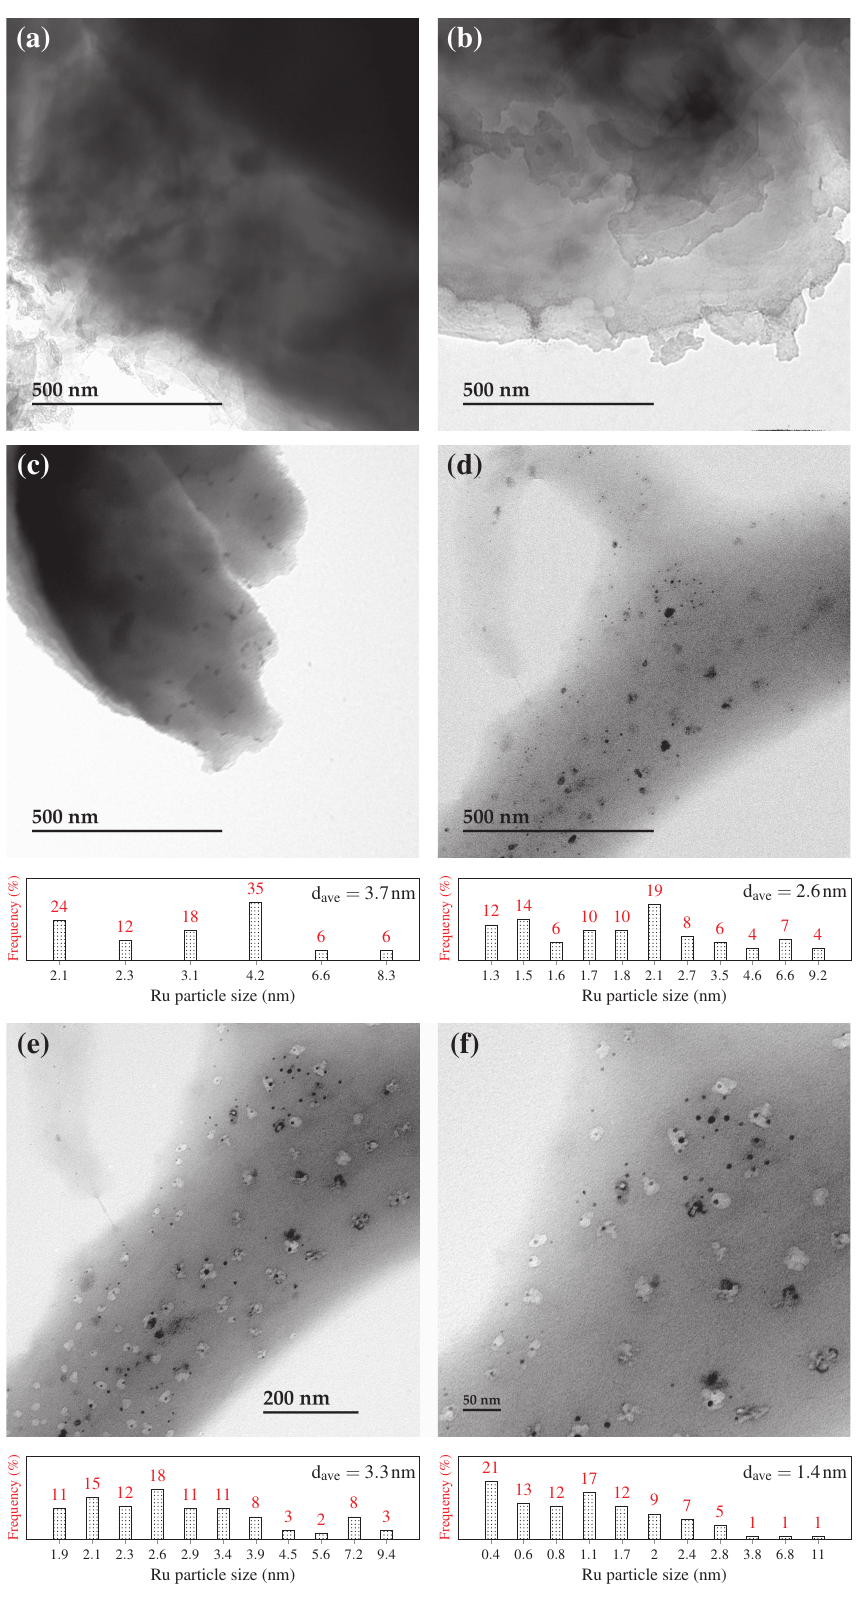
Figure 4. TEM analysis of samples: ( a ) “BC”; ( b ) “OBC”; ( c ) “Ru-BC”; ( d – f )